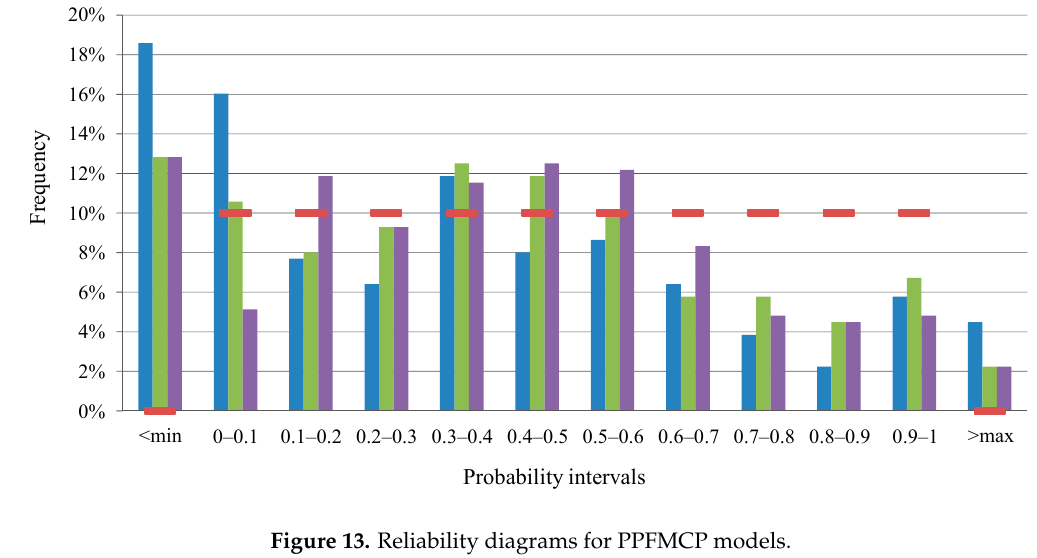
Figure 13. Reliability diagrams for PPFMCP models.